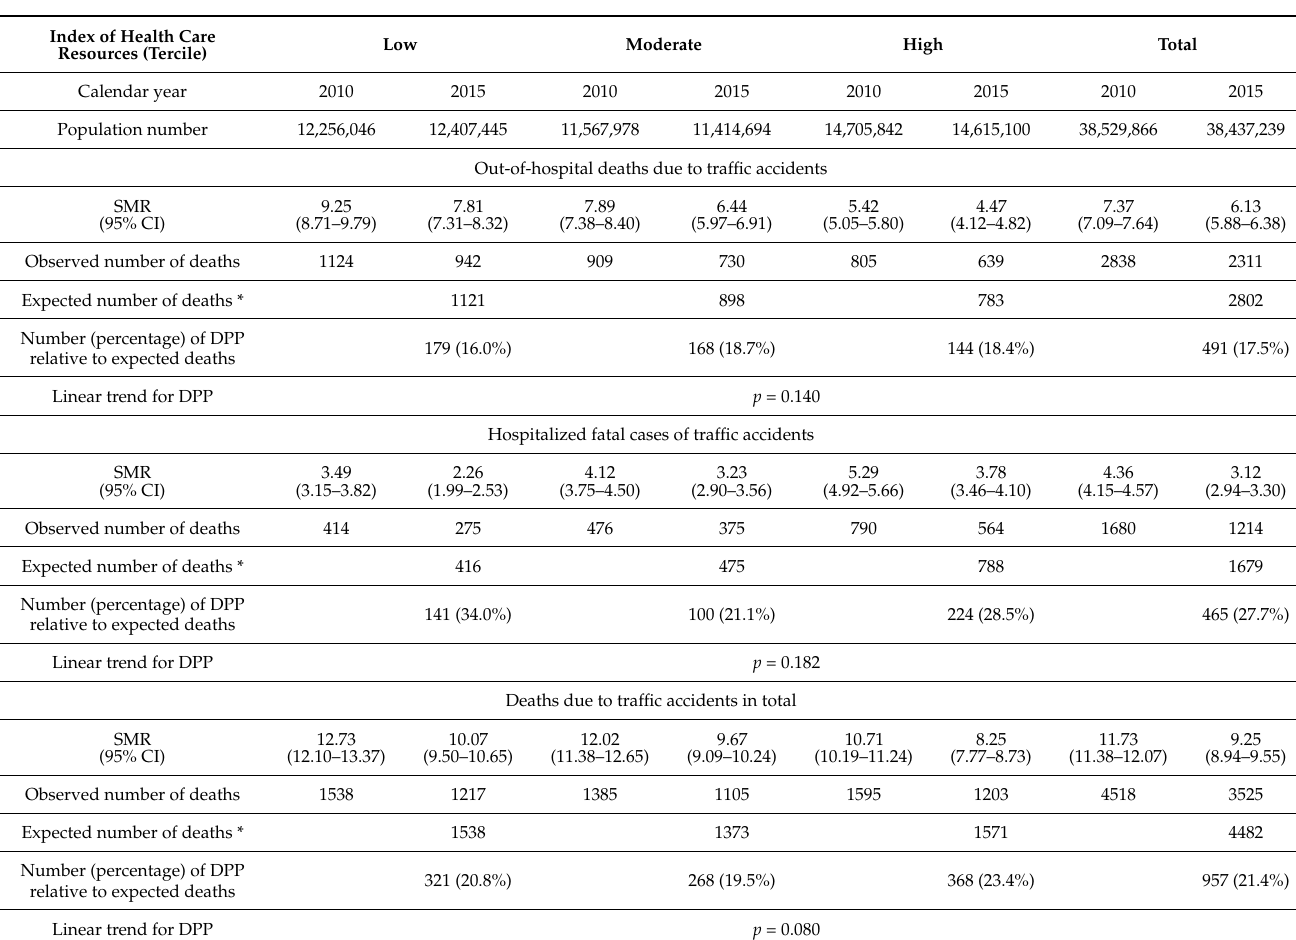
Table 2. Age-standardized mortality rates and deaths prevented or postponed due to transport accidents in Poland in the years 2010 and 2015 sub-region classes according to health care resources